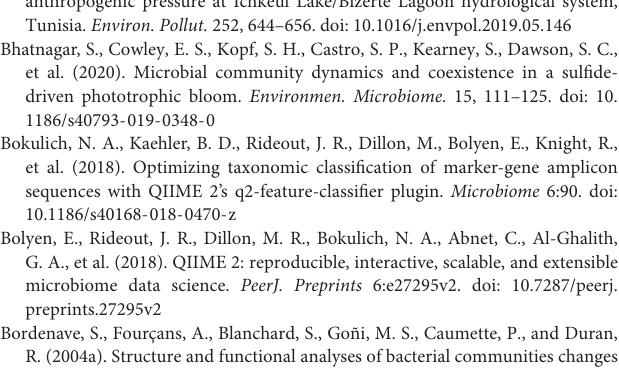
Supplementary Figure 1 | Geographic information system map of Qilianyu lagoon, China. IL (red curve) and OL (blue curve) represent sediments from lagoon zone and surrounding area,